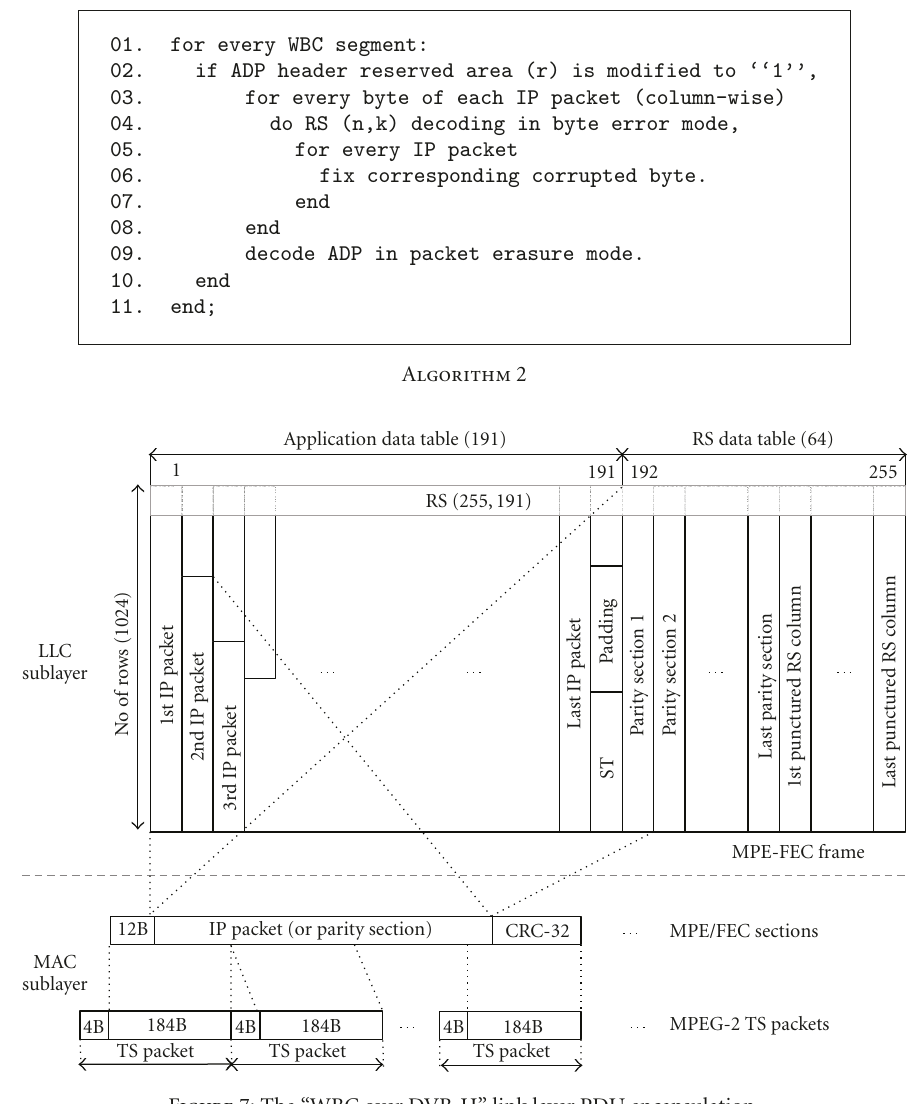
Figure 7: The “WBC over DVB-H” link layer PDU